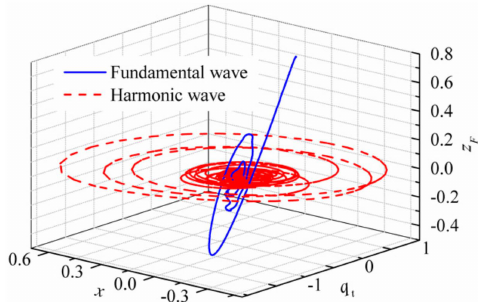
Figure 33. Phase space trajectory of variable responses in an HTGS with an upstream surge tank and an SCTT. Reproduced with permission from [50], Springer Nature, 2016.